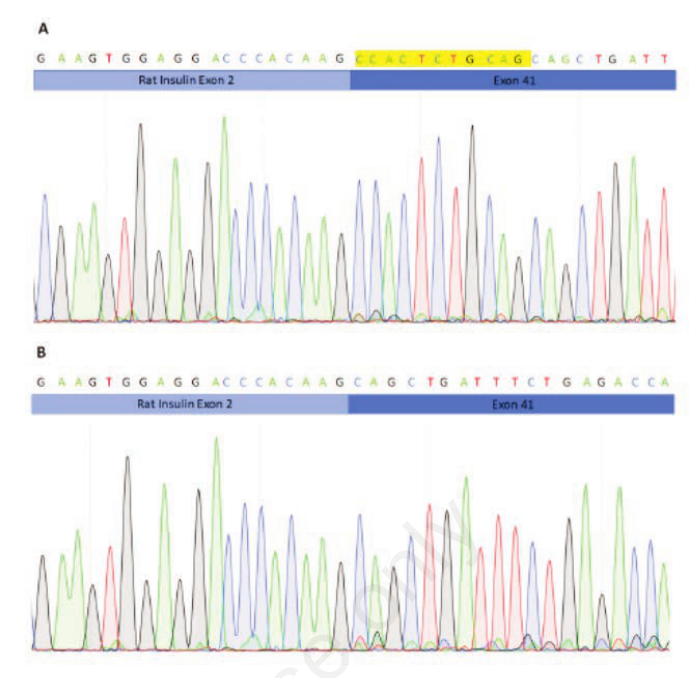
Figure 2. Electropherogram of cDNA sequences at the exon border between vector sequence (rat insulin exon 2) and RYR2 exon 41, for RYR2 WT (A) and the splice variant RYR2 c.6167-2A>G (B). Regions highlighted in yellow represent sequences skipped in RYR2